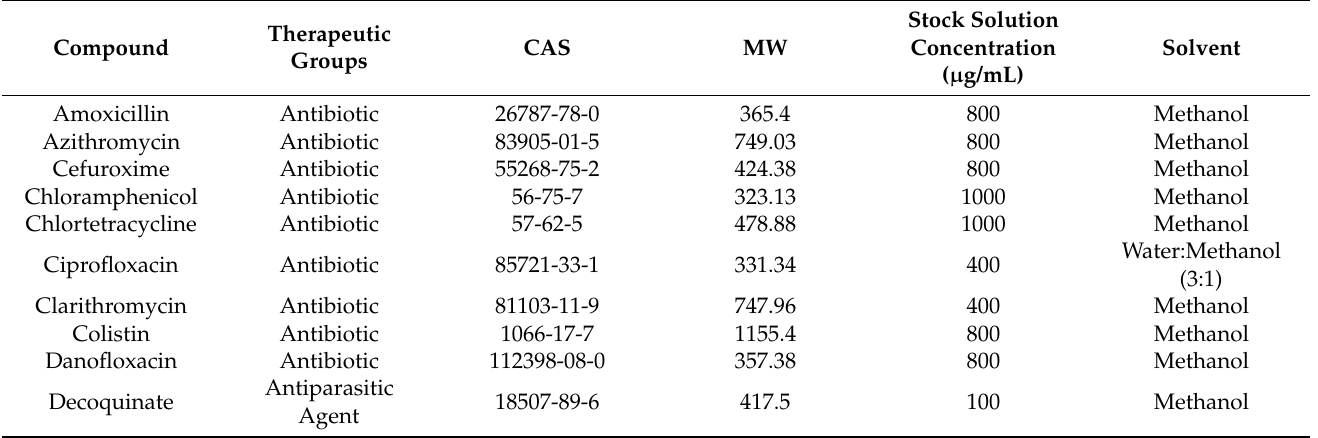
Table 1. Analyte name, therapeutic class, CAS Register Number (CAS), molecular weight (MW) and chemical formula of the selected